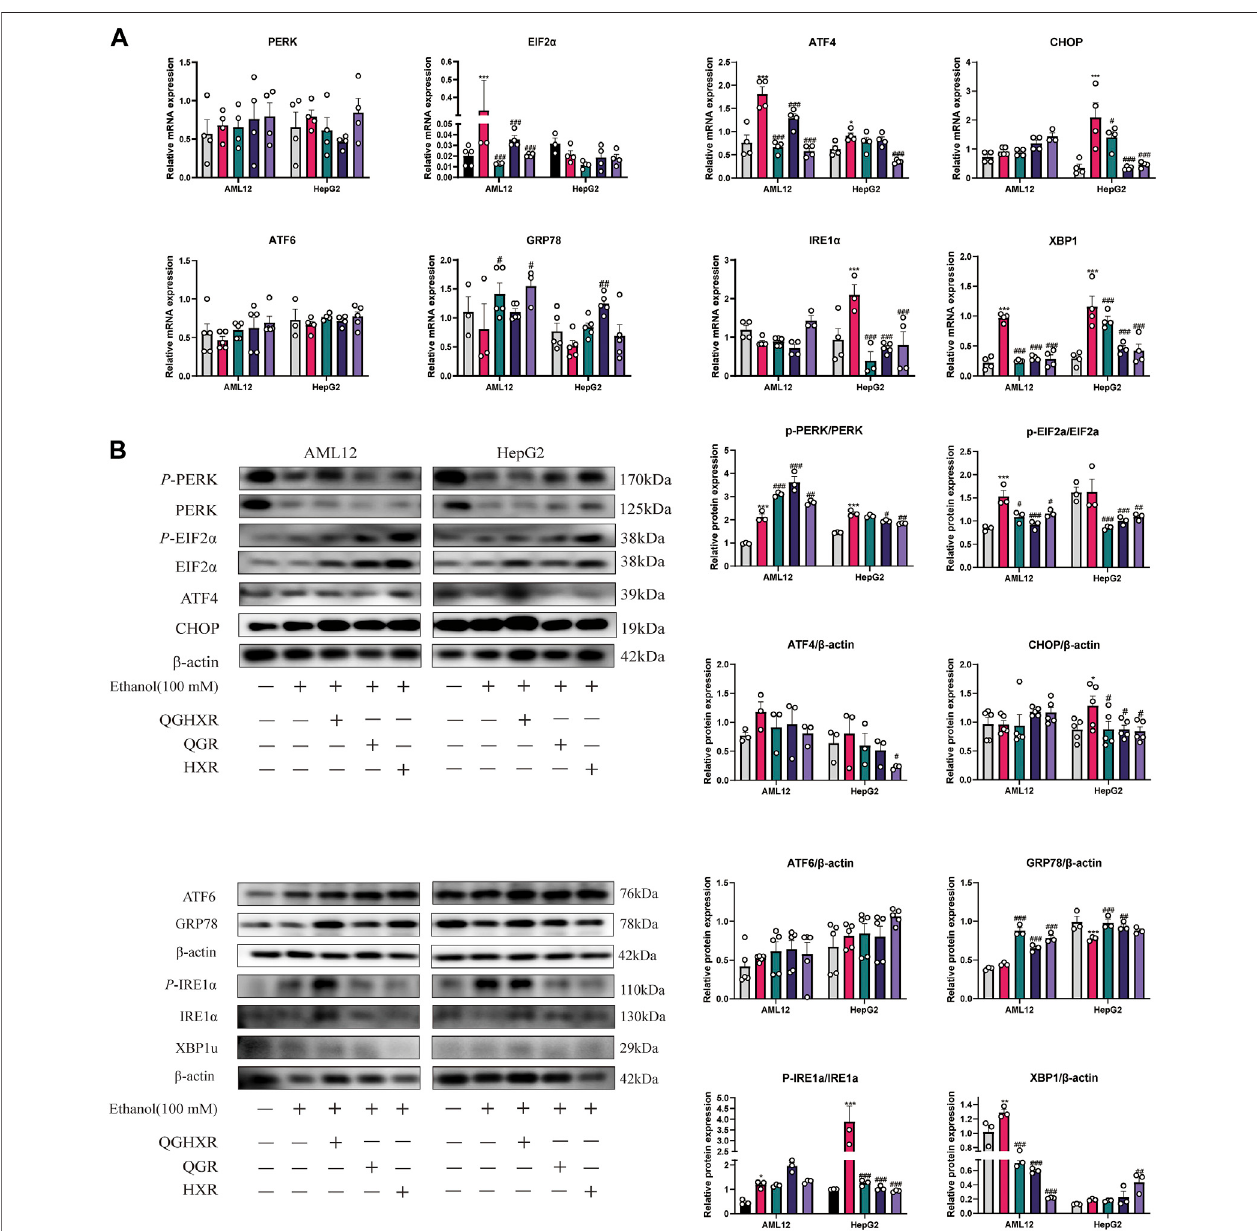
FIGURE 4 | Protective effect of QGHXR against alcohol-induced liver injury in AML12 and HepG2 cell involved modulation of factors related to ERS. (A) mRNA expression in both cell samples; (B) protein expression in both cell samples. Con: normal control group, ethanol: ethanol group (100 mM), ethanol + QGHXR: Qinggan Huoxue Recipe group induced by ethanol; ethanol + QGR: Qinggan Recipe group induced by ethanol; ethanol + HXR: Huoxue Recipe group induced by ethanol. For (A,B) , quanti fi cation of mRNA and protein level expression was normalized to β -actin levels, except protein phosphorylation level expression of PERK, eIF2 α , and IRE1 α was normalized to their prototypes. Data were presented as means ± SEM. Compared with the normal control group, * p < 0.05, ** p < 0.01, *** p < 0.001; Compared with the ethanol group, # p < 0.05, ## p < 0.01, ### p < 0.001.